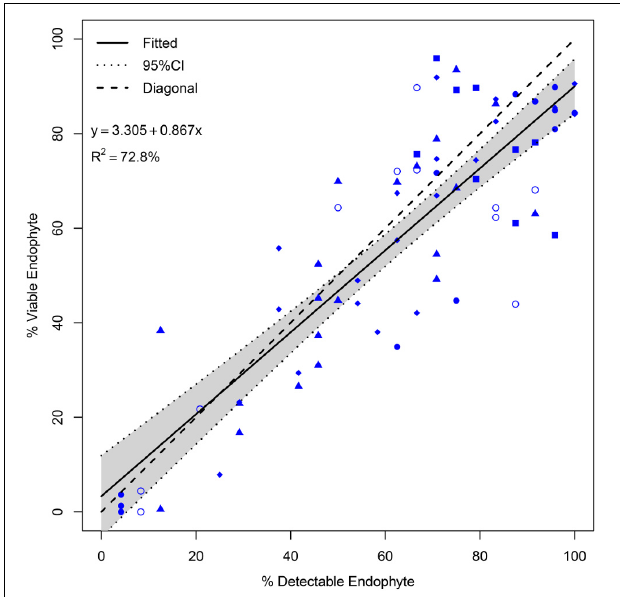
FIGURE 6 | Relationship between AR37 transmission to seedlings (% viable endophyte) and presence in seed (% detectable endophyte) for seed collected at the Grasslands Research Centre (GRLDS) in 2013. Seed from selected parental genotypes within Populations I–V were tested: Pop I, empty circles ( n = 10); Pop II, squares ( n = 9); Pop III solid circles ( n = 12); Pop IV, triangles ( n = 20); and Pop V, diamonds ( n = 20). The fitted line (solid) has an R 2 = 72.8%, and the 95% confidence interval (CI) is shaded in gray.